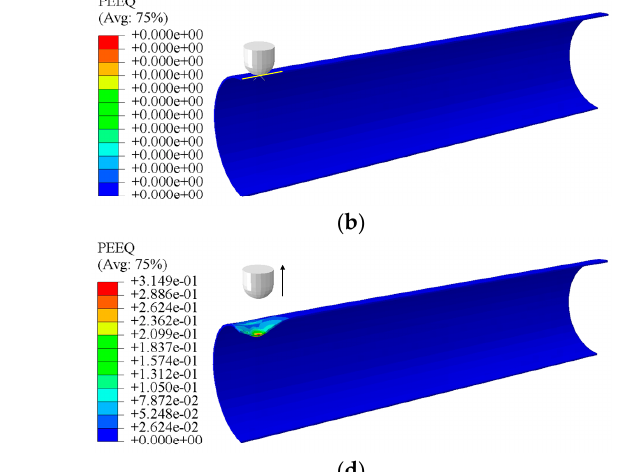
Table 3. Different mesh sizes and amounts for mesh sensitivity analysis.